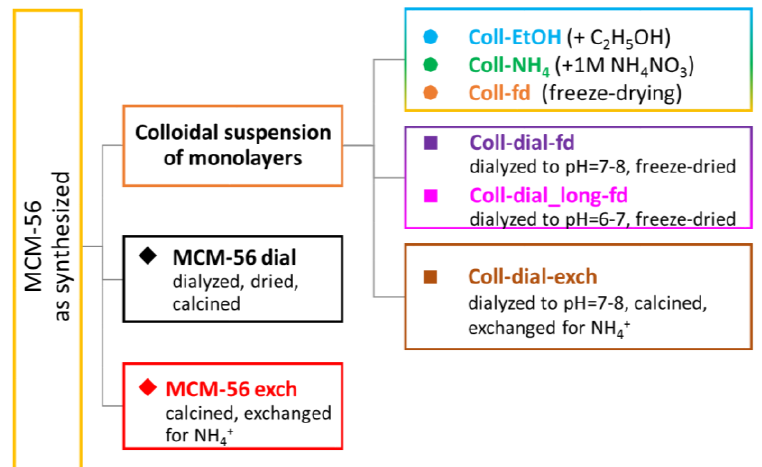
Scheme 1. General outline of the treatments of the MWW colloidal dispersions and solid MCM-56. Samples in this scheme and all figures are coded by individual colors and symbols: diamonds ( ) for the solid MCM-56, circles ( ) for precipitated samples, and squares ( ) for dialyzed samples.